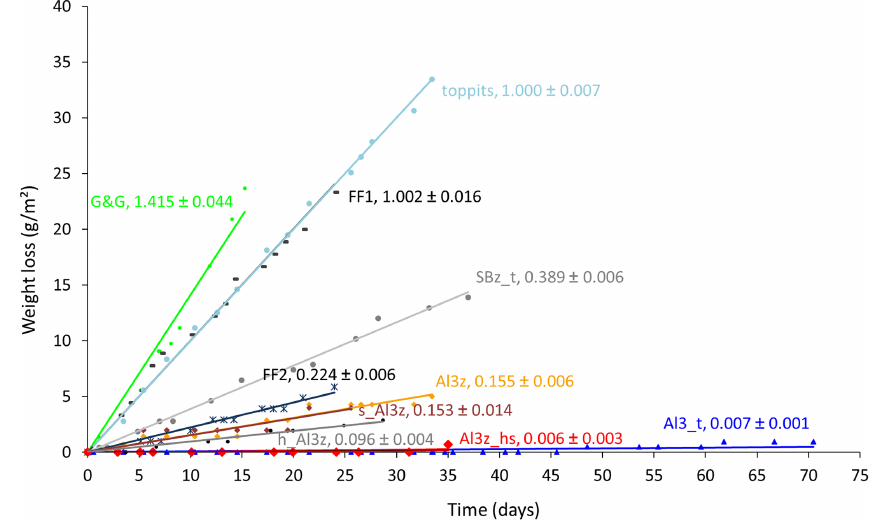
Figure 2. Time series of weight losses normalized to the surface areas of 10 different bags filled with moist soil. Numbers in line labels are slopes of the trend lines and indicate average weight loss rates and uncertainties in g ( m 2 d ) − 1